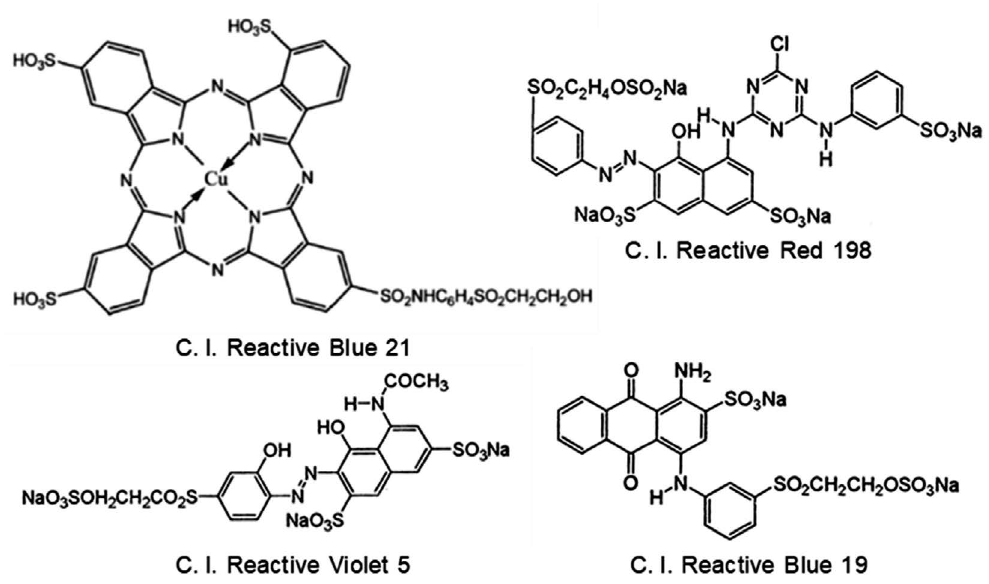
Figure 1. Structures of RB21, RB19, RV5, and